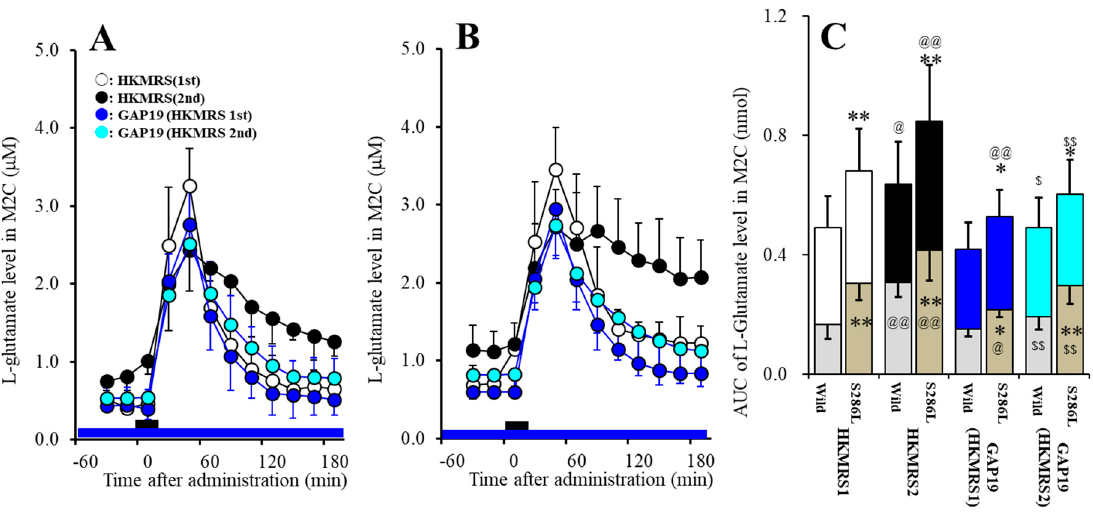
Figure 8. E ff ects of local administration of GAP19 (Cx43 inhibitor) into the M2C on repetitive potassium-evoked L-glutamate release in the M2C of wild-type ( A ) and S286L-TG ( B ). Perfusion medium in the M2C was commenced with MRS containing with or without 100 µ M GAP19. After the stabilization of L-glutamate level in the M2C, the perfusion medium was switched from MRS to HKMRS containing the same agent for 20 min (1 st potassium-evoked stimulation) (GAP19 non-treated with 1 st stimulation: opened circles, GAP19 administered with 1 st stimulation: red circles). After the 1 st potassium-evoked stimulation, the perfusate was returned to MRS containing the same agent for 240 min (recovery). Following recovery, the perfusate was switched to HKMRS containing the same agent for 20 min again (2 nd potassium-evoked stimulation). After the 2 nd potassium-evoked stimulation, perfusate was returned to MRS containing the same agent (GAP19 non-treated with 2 nd stimulation: blue circles, GAP19 administered with 2 nd stimulation: green circles). Ordinates indicate mean extracellular L-glutamate level ( µ M) (N = 6), and abscissas indicate time after 1 st or 2 nd potassium-evoked stimulations (min). Black bars indicate the perfusion with HKMRS (1 st and 2 nd potassium-evoked stimulation). Blue bars indicate the perfusion with 100 µ M GAP19 into the M2C. ( C ) indicates the AUC value of extracellular L-glutamate level (nmol) before (basal extracellular L-glutamate level) and after potassium-evoked stimulation (from 20 to 180 min) of Figure 8A,B. Gray columns in Figure 8C indicate the AUC values of basal extracellular levels of L-glutamate in Figure 8A,B. * P < 0.05, ** P < 0.01; relative to wild-type, @ P < 0.05, @@ P < 0.01; relative to HKMRS (1 st ) and $ P < 0.05, $$ P < 0.01 relative to HKMRS (2 nd ) by MANOVA with Tukey’s post hoc test.